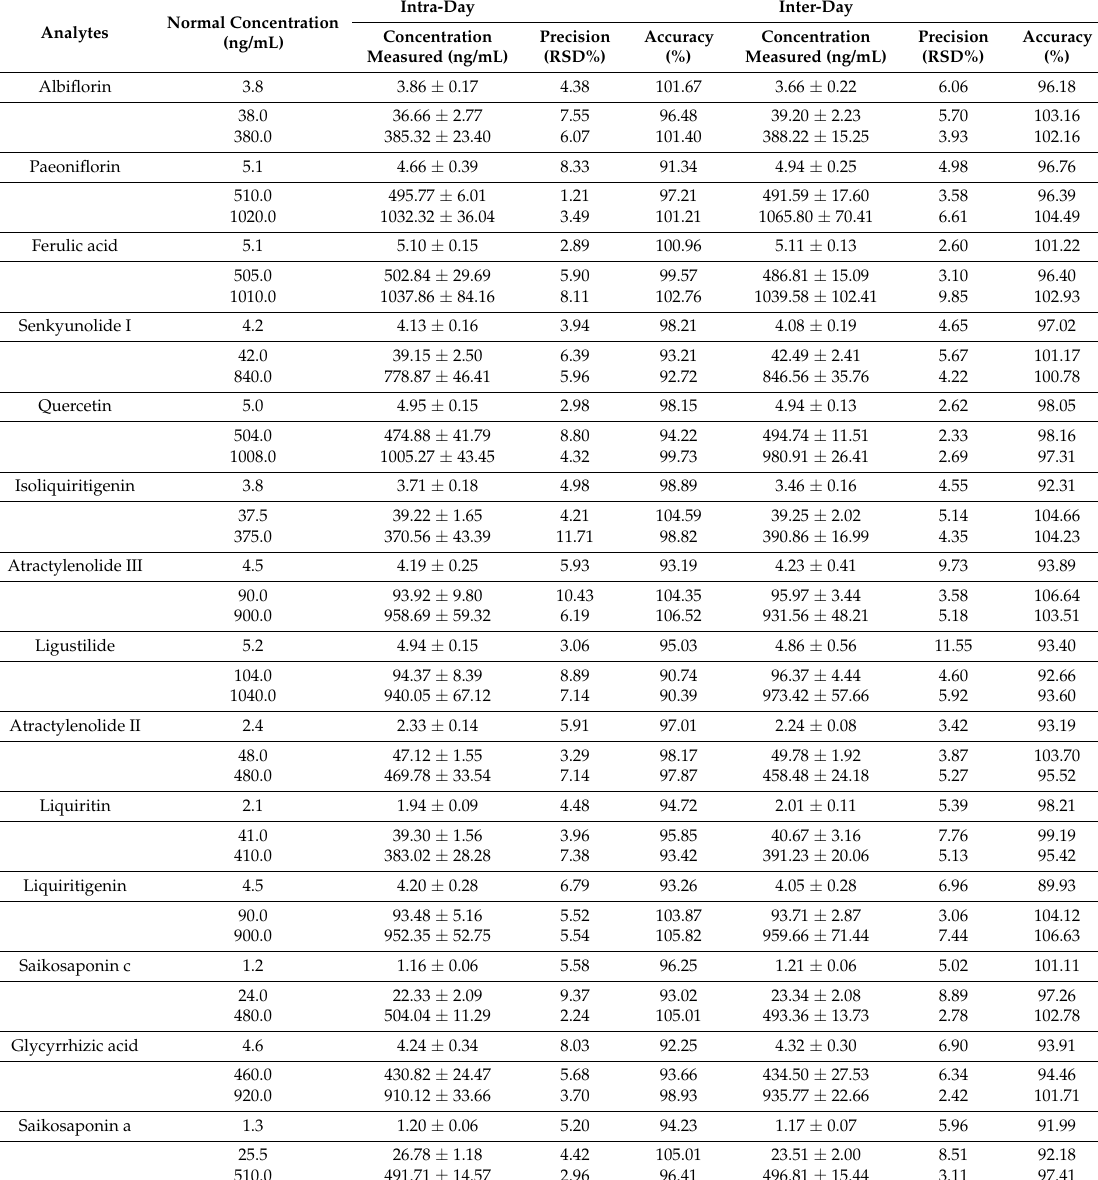
Table 2. Intra-day and inter-day precision and accuracy ( n =